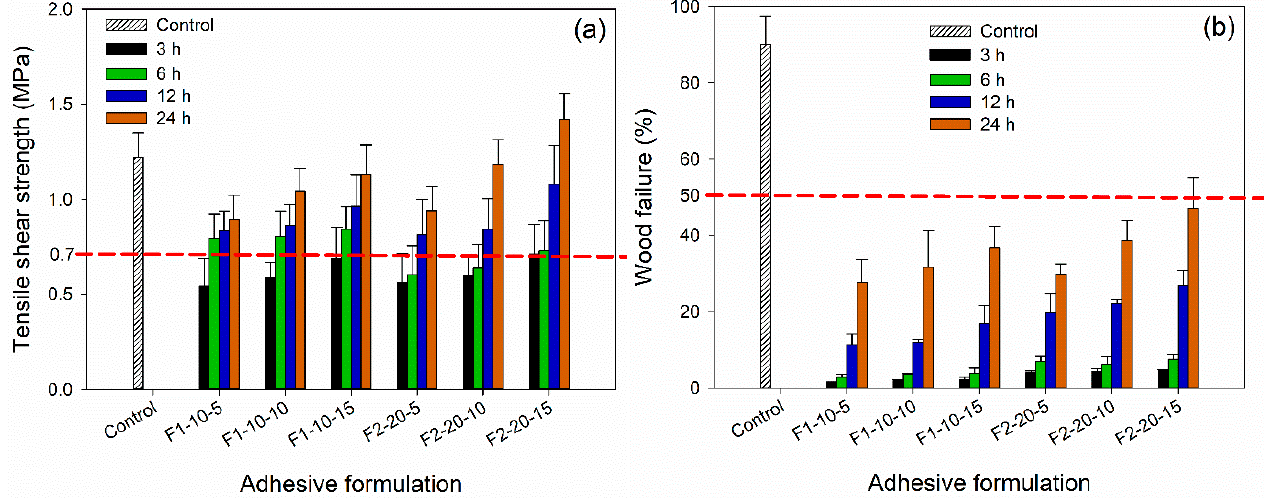
Figure 7. The bonding strength of plywood bonded with PVOH–tannin–hexamine-based adhesives. ( a ) Tensile shear strength, ( b ) wood failure .